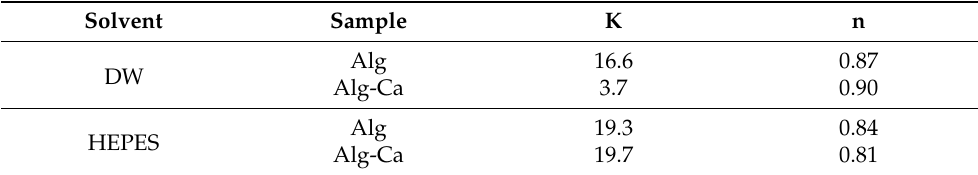
Table 1. Calculated value of K and n from power-law